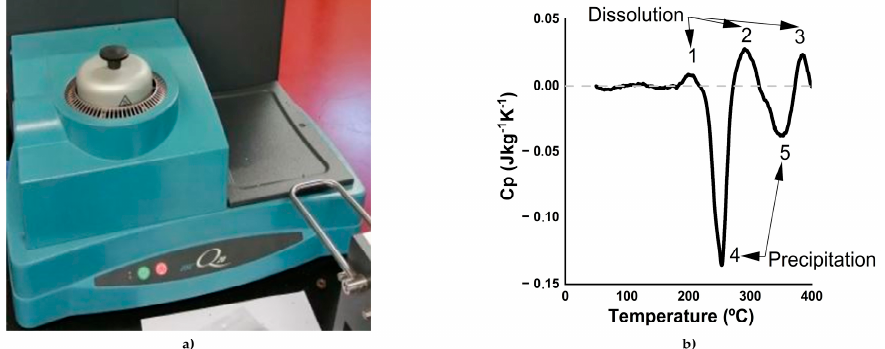
Figure 3. ( a ) ‘DSC Q20’ equipment used for calorimetry analysis. ( b ) Normalized specific heat capacity curve for a heating rate of 0.09 K/s.